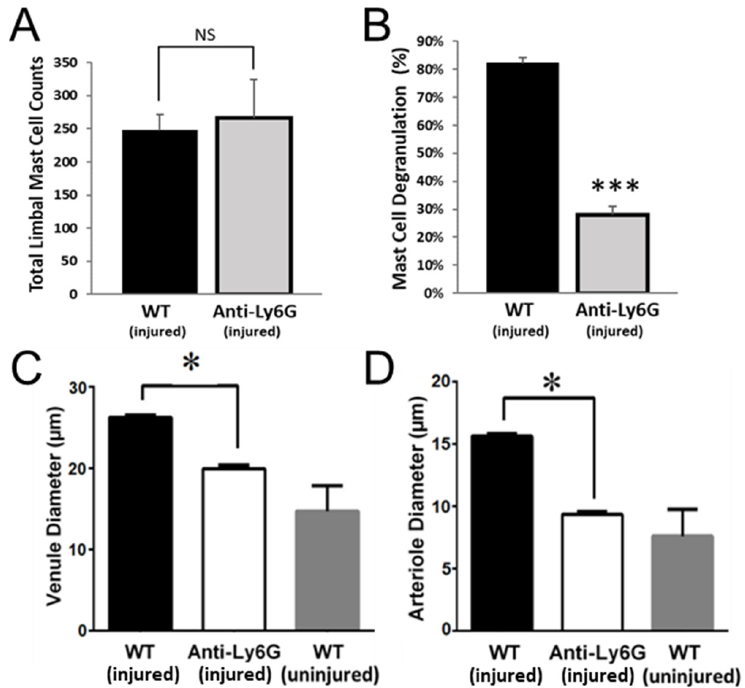
Figure 6. Anti-Ly6G antibody treatment reduces mast cell degranulation and limbal vessel expansion. ( A – D ) Corneas were collected and immunostained 24 h after wounding. ( A ) Analysis of limbal mast cell counts and ( B ) mast cell degranulation. ( C ) Venule and arteriole ( D ) diameters were measured at the limbus. n = 6 per group, * p ≤ 0.05, *** p ≤ 0.001 and NS = Not Significant.